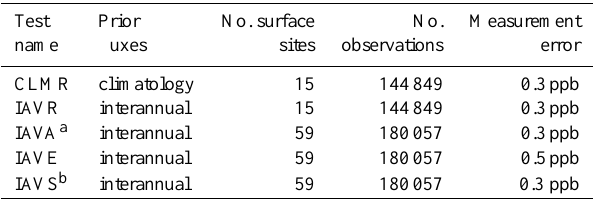
Table 4. Overview of inversion sensitivity